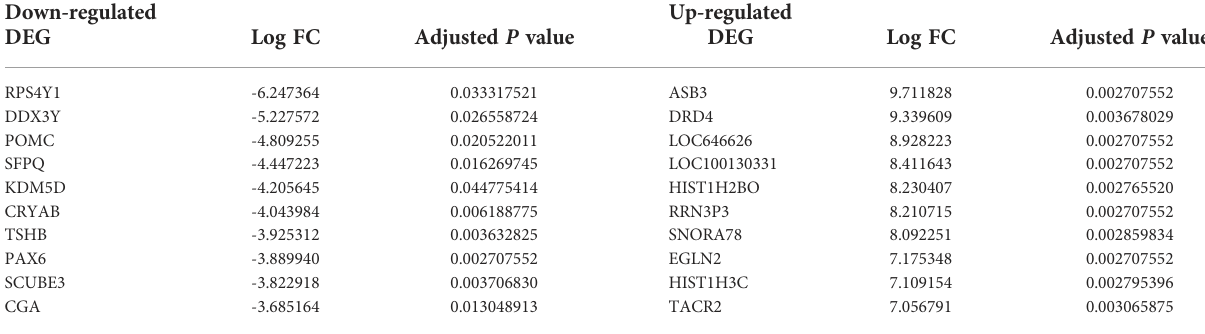
TABLE 1 The top 10 up- and downregulated DEGs between NFPA and normal samples. Down-regulated